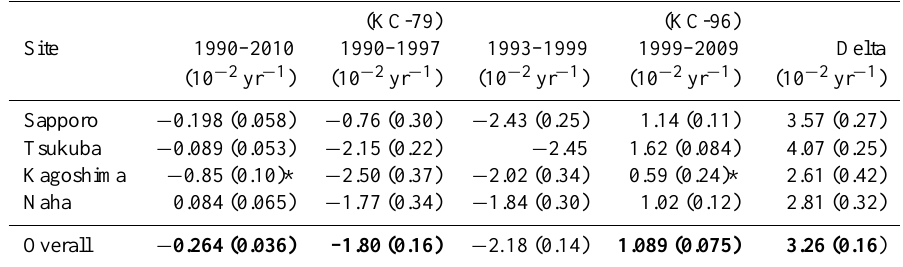
Table 4a. Trends in the CFs for the Japanese ozonesonde stations. The calculations are based only on those sondes that reach a minimum altitude of 32km (10.5hPa) before bursting. The “Delta” column represents the difference in the trends of the 1999–2009 period and the 1993–1999 period. Numbers in parentheses represent one standard deviation uncertainties.